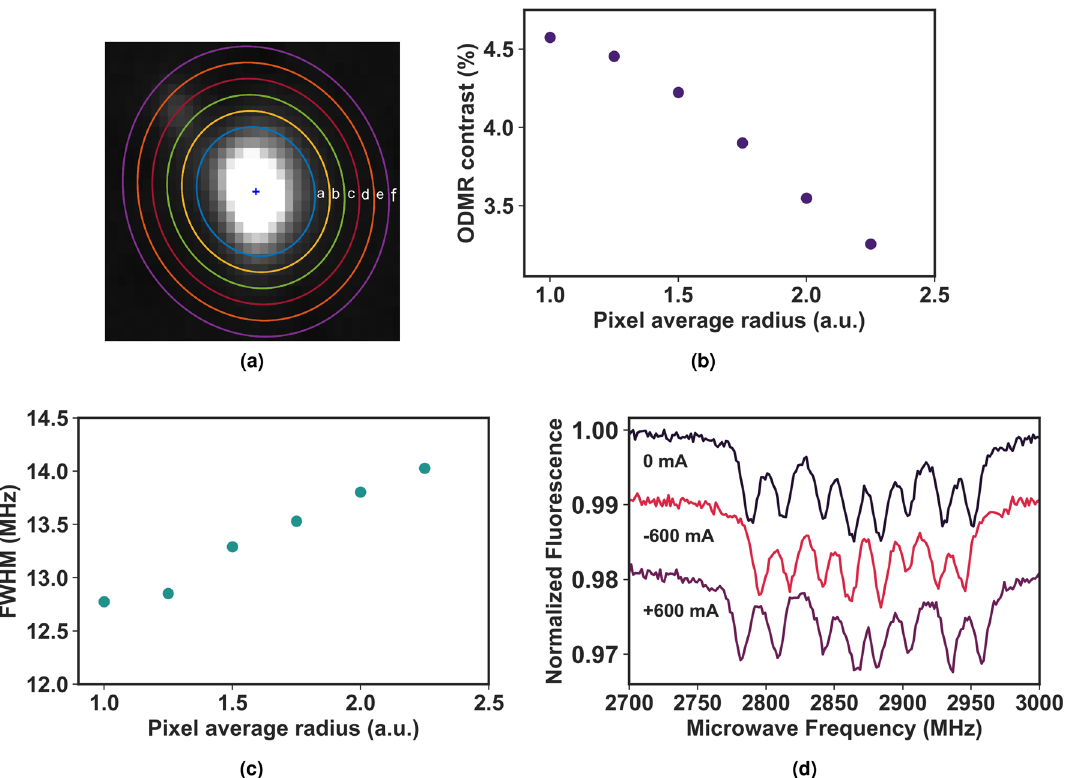
Figure 3. ( a ) A fluorescent diamond spot with different pixel region radius encircled in different colors and the corresponding ODMR contrast ( b ) and FWHM ( c ) for different pixel region. The pixel areas named from a to f in panel a corresponds to the pixel region radius from 1 to 2.5 in panels b and c. ( d ) ODMR resonance spectra in presence of a bias field at 0 mA (black) and 600 mA (red) and -600 mA (violet) in the current-carrying